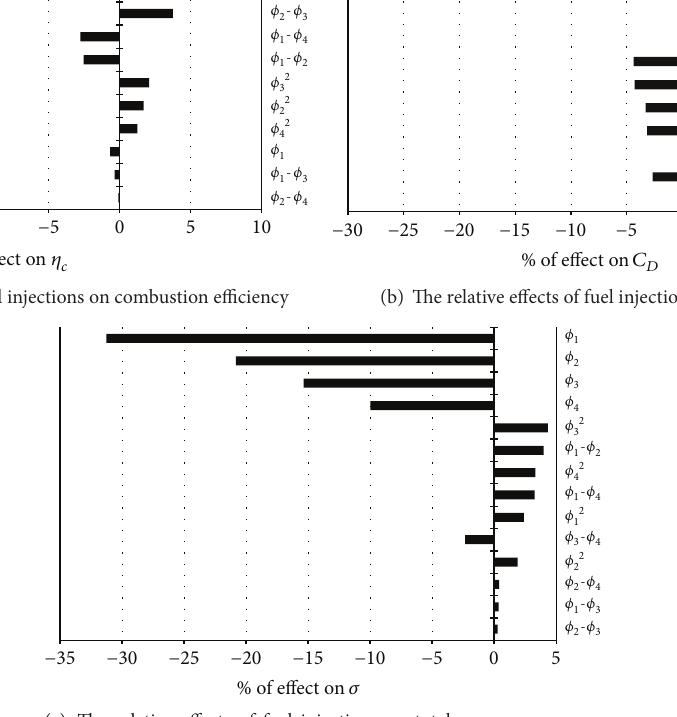
Figure 13: Pareto graph for the objective